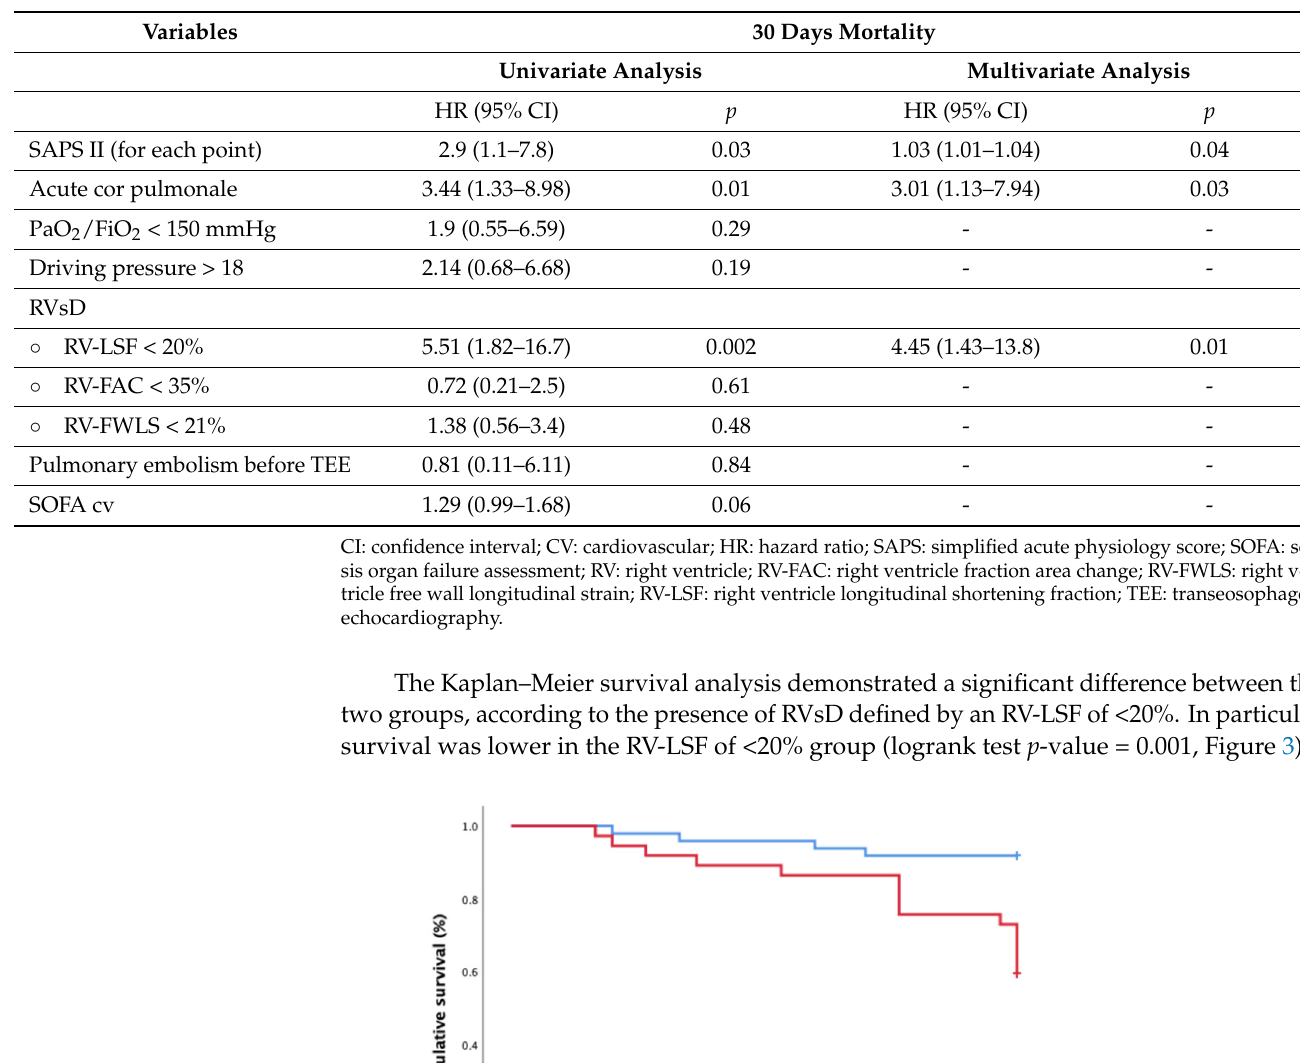
Table 4. Univariate and multivariate Cox analysis of variables associated with 30-day mortality.